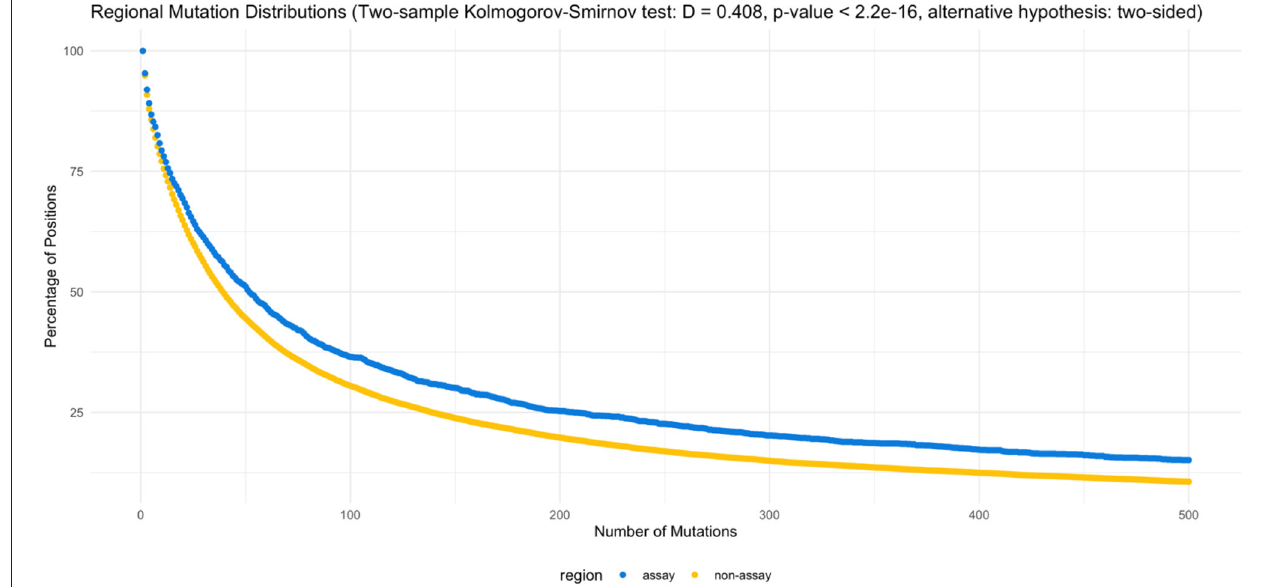
FIGURE 3 | Regional mutation distributions. The two-sample Kolmogorov-Smirnov test rejected the null hypothesis ( α = 0.05), supporting the elevated number of mutations observed in the assay regions (D = 0.408, p < 2.2e − 16, alternative hypothesis: two-sided). Supplementary Tables 5 , 6 list the counts by position and percentage of mutations by